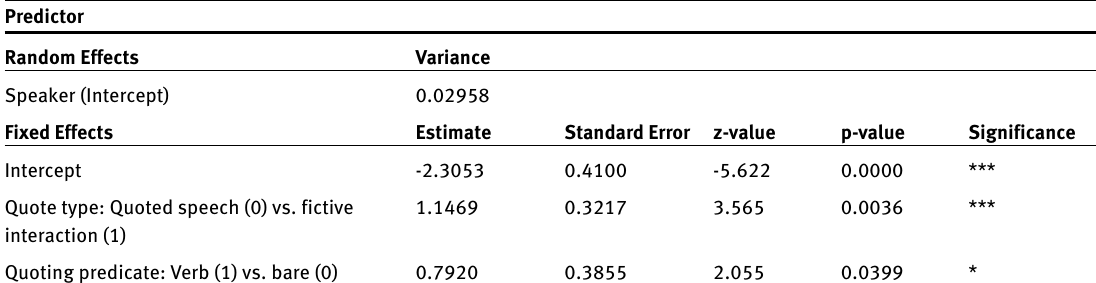
Table 11: The best generalized mixed-effects regression model for initial utterances in Quoted Monologue sequences. Only predictors for the best-fit model are shown. Negative estimates indicate lower probability. Significance is indicated as follows: